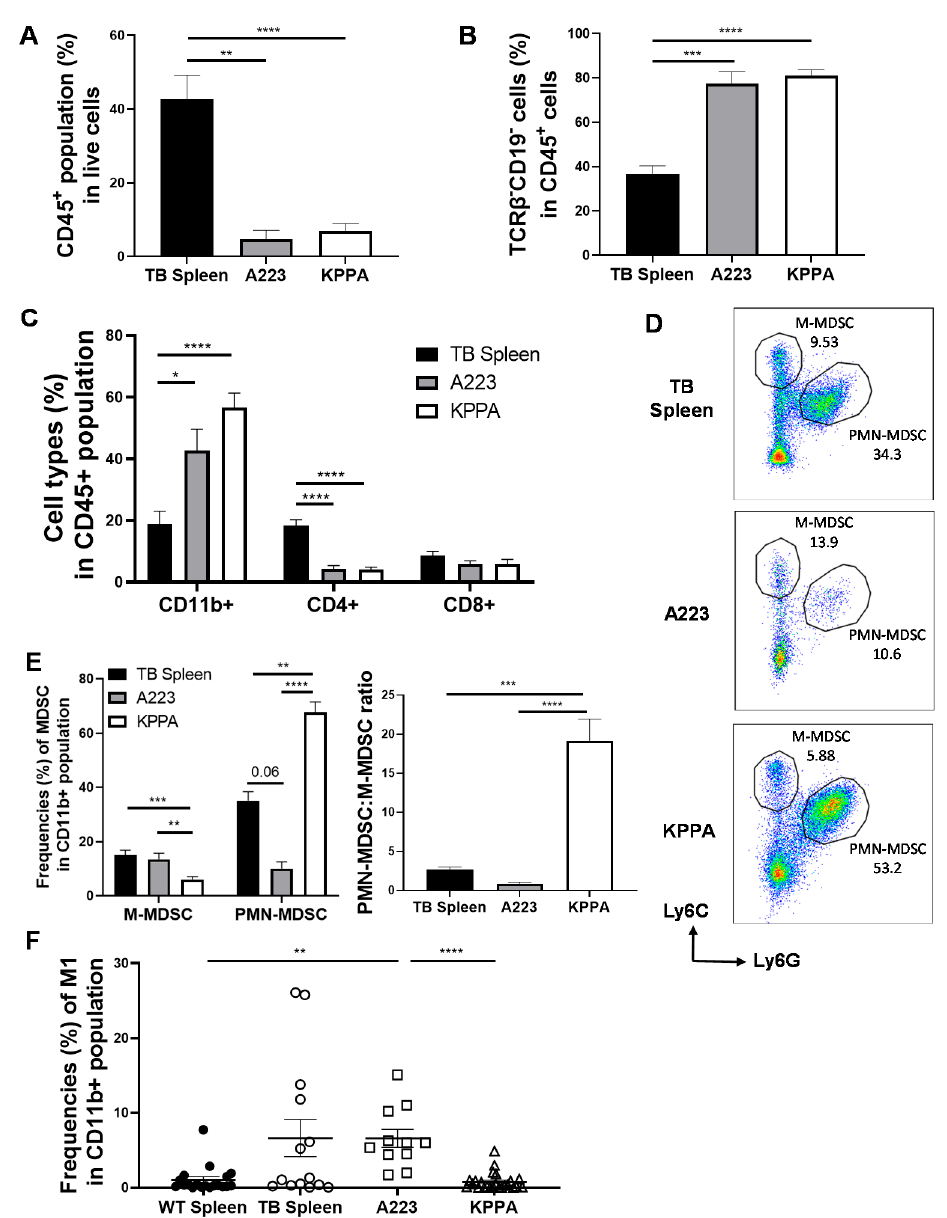
Figure 3. Characterization of the immune tumor microenvironment (TME) of KPPA tumors. Flow cytometry were performed for tumor-bearing (TB) splenic control ( n = 14), or the TILs from A223 ( n = 11) and KPPA ( n = 25) tumors for all panels shown below. ( A ) Quantification of the percentage of total CD45 + hematopoietic population. The percentage of CD45 + population was significantly greater in TB splenic control (42.62 ± 6.50) than A223 ( p = 0.0014) or KPPA ( p ≤ 0.0001) tumors; ( B ) Quantification of the percentage of CD45 + TCR β − CD19 − population (non-T and non-B cells). The percentage of CD45 + TCR β − CD19 − population was significantly lower in TB splenic control (36.47 ± 3.86) than A223 (77.44 ± 5.43, p = 0.0004) or KPPA (80.94 ± 2.69, p ≤ 0.0001) tumors; ( C ) Quantification of the percentage of CD11b + , CD4 + , or CD8 + cells in CD45 + population of TB spleen, A223 or KPPA tumors. For CD11b + cells: TB splenic control (18.94 ± 3.99) was significantly lower than A223 (42.11 ± 6.84, p = 0.05) and KPPA (56.57 ± 4.70, p ≤ 0.0001) tumors. For CD4 + cells: A223 (4.26 ± 1.13, p ≤ 0.0001) and KPPA (4.20 ± 0.61, p ≤ 0.0001) tumors were significantly lower than TB splenic control (17.43 ± 2.00). For CD8 + cells: no significant di ff erences between KPPA tumors (5.92 ± 1.44), A223 tumors (5.87 ± 1.05) and TB splenic control (7.92 ± 1.49); ( D ) Representative flow plots for di ff erent MDSC populations. M-MDSC (CD11b + Ly6G − Ly6C high ) vs. PMN-MDSC (CD11b + Ly6G + Ly6C low ); ( E ) Left panel: Quantification of the percentage of M-MDSC vs. PMN-MDSC in indicated groups. There was no di ff erence in